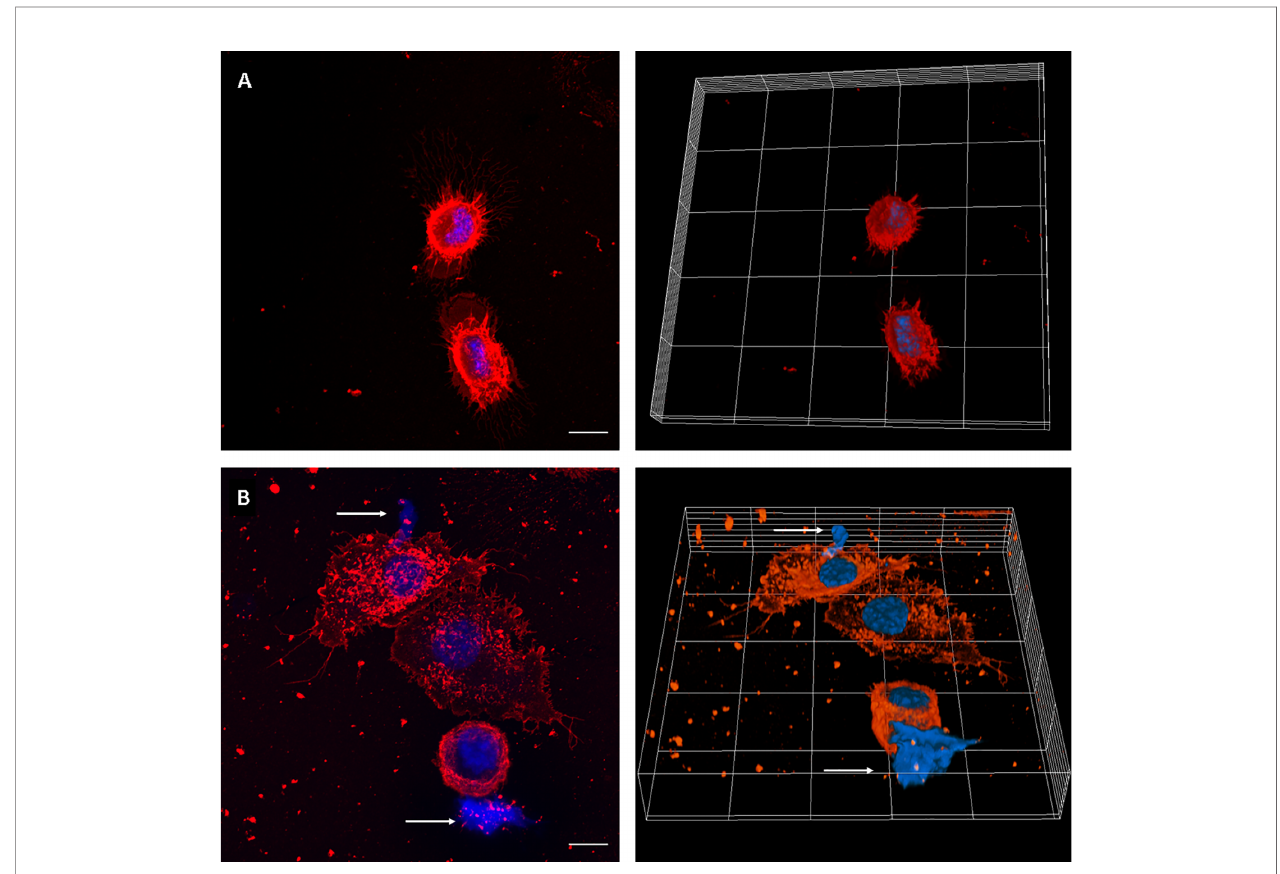
FIGURE 1 | MET release in PMA-treated J774A.1 macrophages. Confocal microscopy images of (A) Unstimulated cells, and (B) cells incubated with PMA (200 µM) for 30 minutes. The left panels show maximum intensity z-projection of the image stack; the right panels show 3D models of cells. WGA staining is shown in red and DNA in blue. The arrows point out the presence of METs. The scale bar represents 10